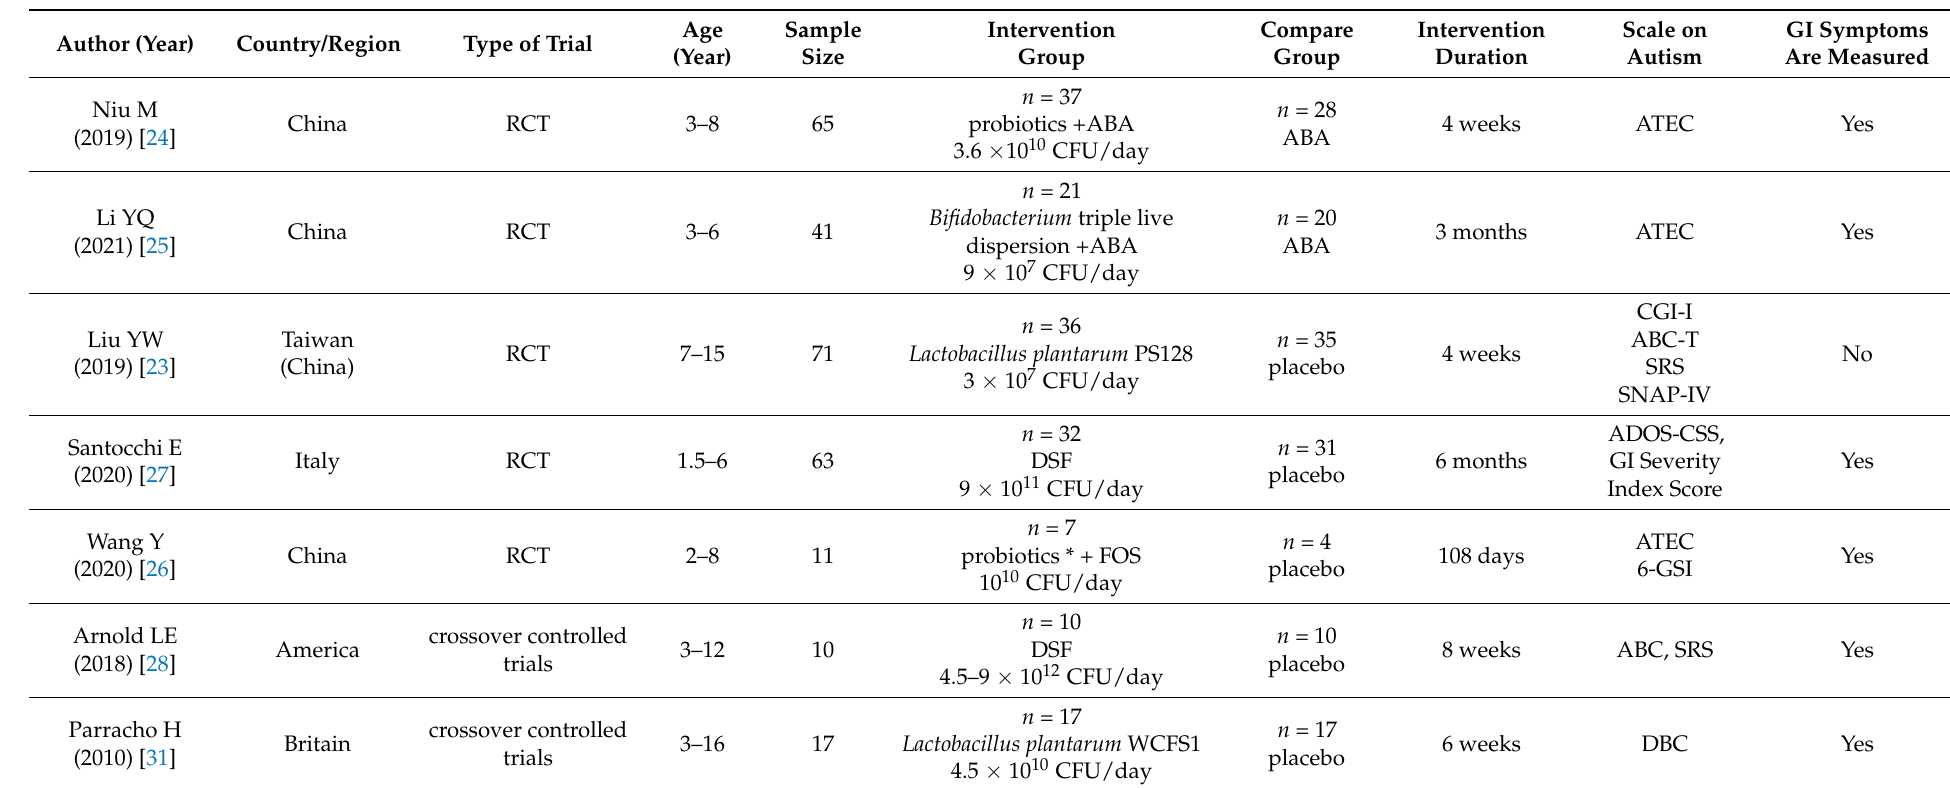
Table 1. Basic characteristics of studies included in the systematic